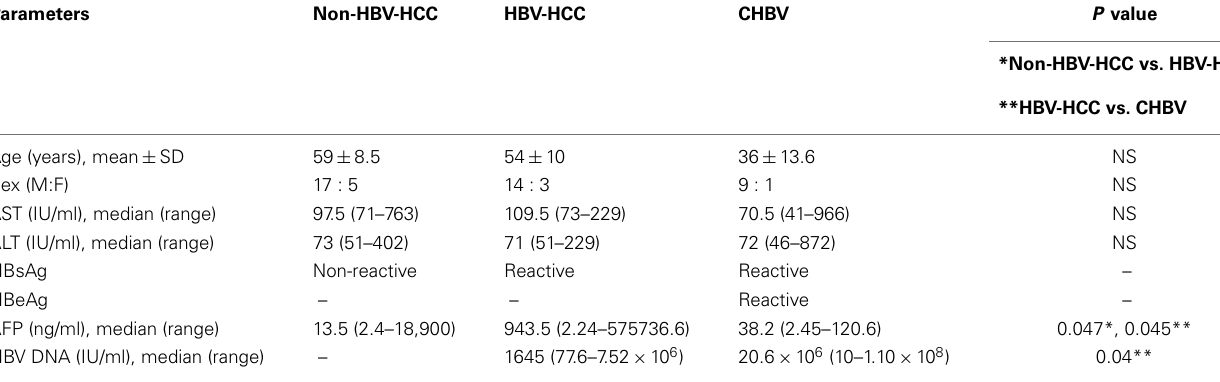
Table 2 | Clinical and virological characteristics of subjects recruited in the study .